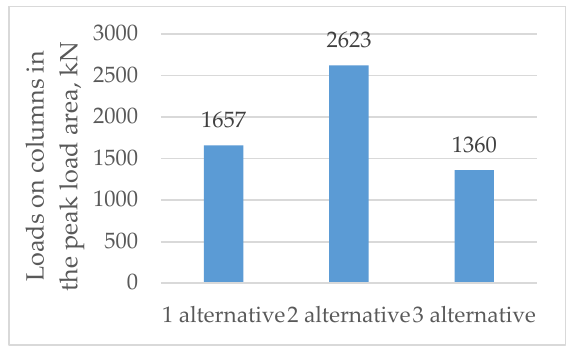
Figure 9. Comparison of maximum loads on columns in the peak load area (kN).